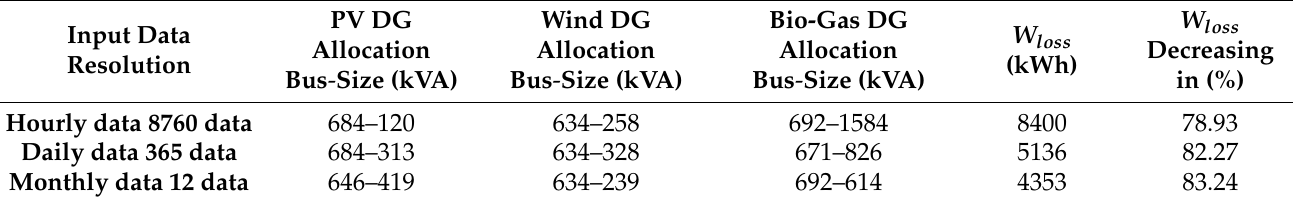
Table 11. Impact of the input data resolution (Opt 1 optimization problem with W loss objective).